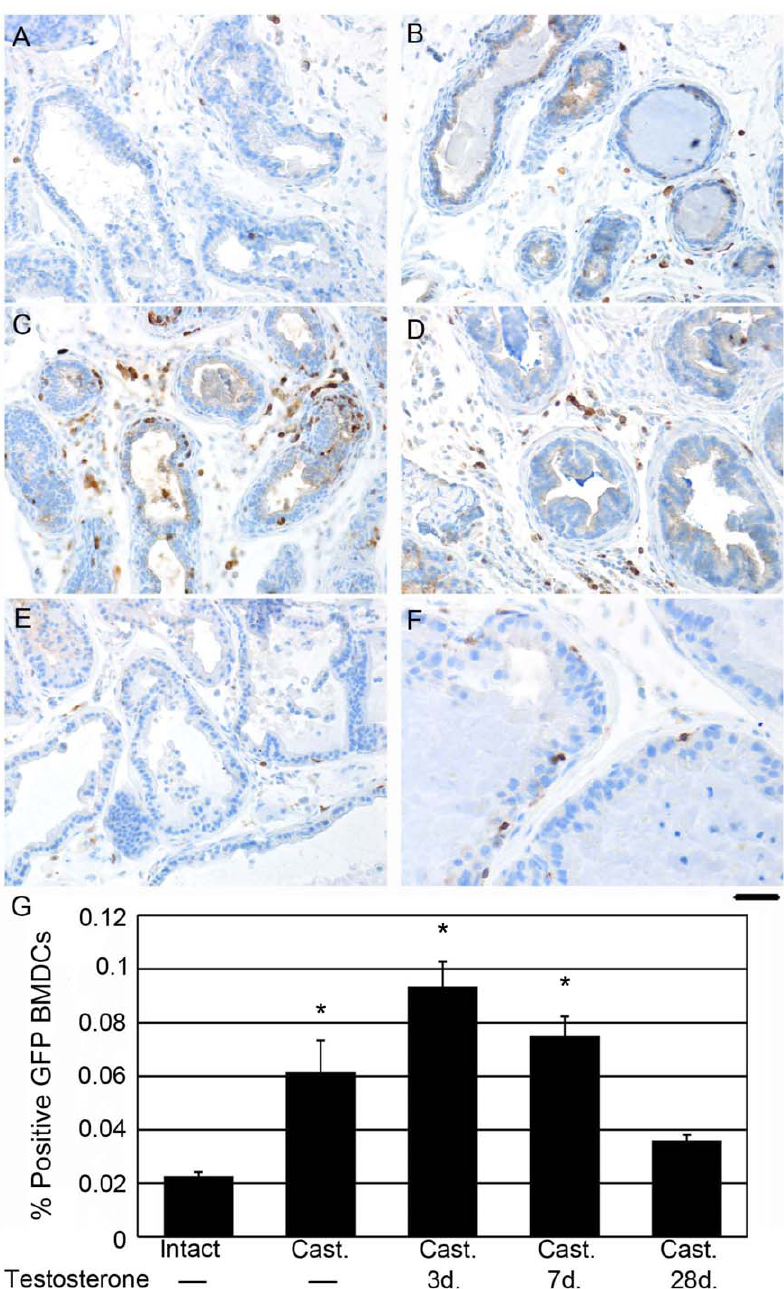
Figure 1. BMDCs were recruited to the prostate during regrowth. GFP-BMDC (brown) recruitment was localized in prostates of GFP chimeric mice. BMDCs were quantitated in prostates of A) intact mice, B) two months post-castration, C) castrated mice supplemented with exogenous testosterone for three days, D) castrated mice supplemented with exogenous testosterone for seven days, and E) castrated mice supplemented with exogenous testosterone for 28 days. F) Higher magnification of castrated prostates supplemented with exogenous testosterone for 28 days indicated BMDC recruitment to the epithelial ductal compartment. Scale bar indicates 50 m m for panels A–E and 25 m m for panel F. G) The bar graph quantifies the percentage of GFP-positive BMDCs recruited to the prostate at the indicated time points during regrowth. Oneway ANOVA was performed to test differences between the experimental and control groups (n=3 per group), followed by Dunnett’s post-hoc tests. Statistically significant values are indicated with * in the bar graph. Error bars indicate standard deviation. The omnibus of F statistic from the ANOVA was 43.3 with 4 and 10 degrees of freedom (p , 0.0001). Dunnett’s post-hoc tests showed differences betweenintact(mean =0.0227) andcastrated(cast) (mean =0.0615) (p , 0.0003), cast + 3dT (mean =0.00936) (p , 0.0001), andcast + 7dT (mean =0.0750) (P , 0.0001). The intact group did not differ from cast + 28dT (mean =0.0360) (p , 0.1629).